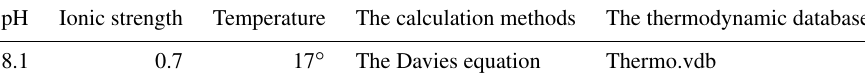
Table A2. The Visual MINTEQ 3.1 software condition.